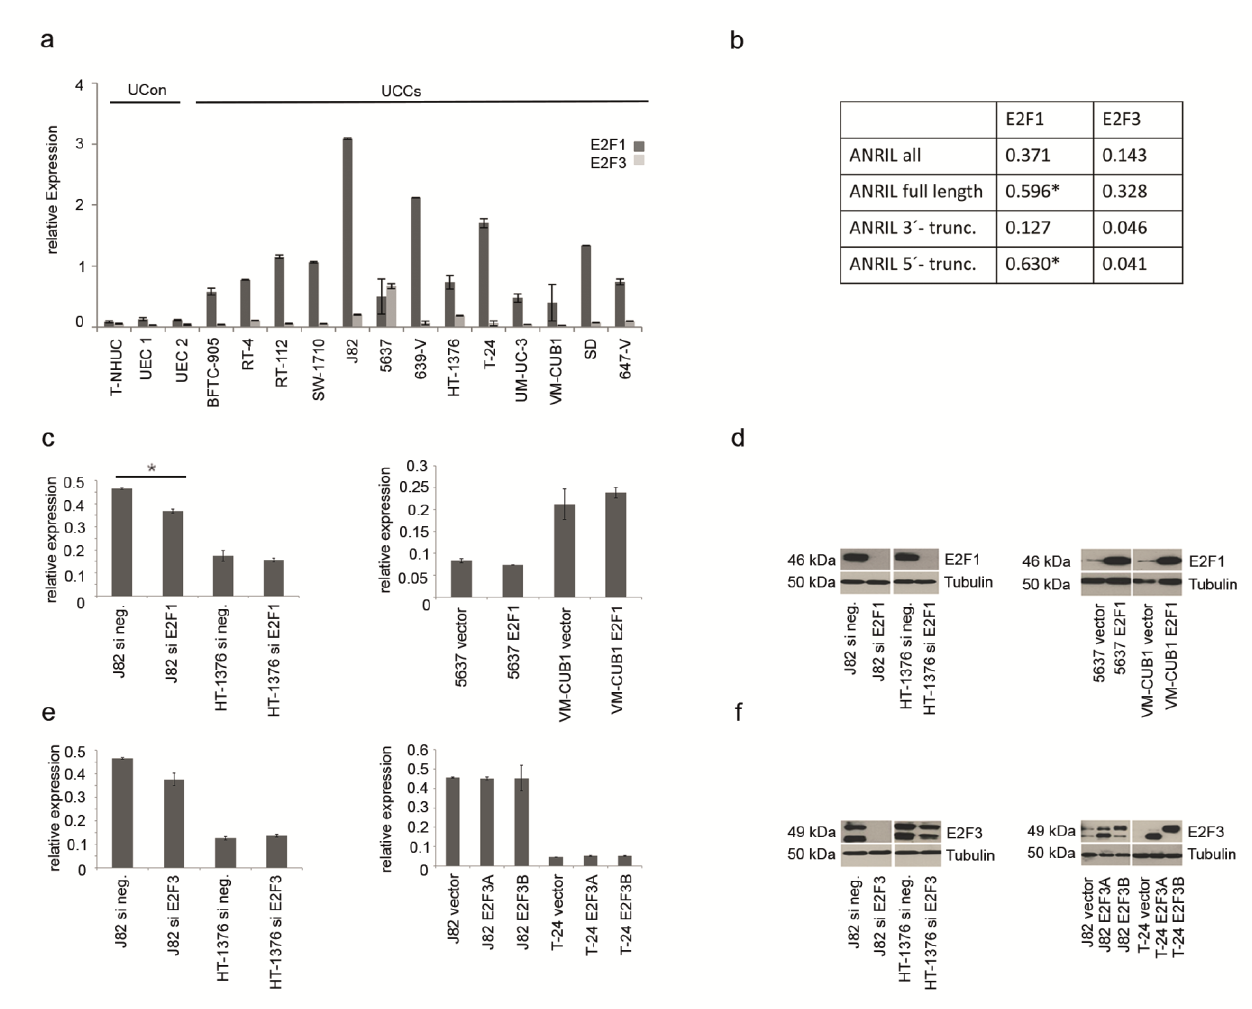
Figure 2. ( a ) mRNA expression of E2F1 (dark grey bars) and E2F3 (light grey bars) was determined in UCCs and UCon by qRT-PCR and normalized to TBP . ( b ) Expression levels of E2F factors in UCCs and controls were correlated with that of ANRIL transcripts by calculating the Pearson correlation coefficient ( * p ≤ 0.05). ( c ) Relative overall ANRIL expression (“ANRIL all”) was determined by qRT-PCR after siRNA-mediated knockdown of E2F1 (left panel; * p ≤ 0.05) or transient ectopic expression (right panel). Efficiency of E2F1 knockdown and overexpression was verified on the protein level ( d ). Similarly, ANRIL expression was measured after siRNA-mediated knockdown of E2F3 (left panel) or transient ectopic expression (right panel). Again, expression modulation of E2F3 was checked on the protein level ( e ). The two different isoforms of E2F3 (A and B) were overexpressed separately by the respective plasmid. However, the siRNA targeted both isoforms as shown in ( f ). The siRNA knockdown in HT-1376 cells was less